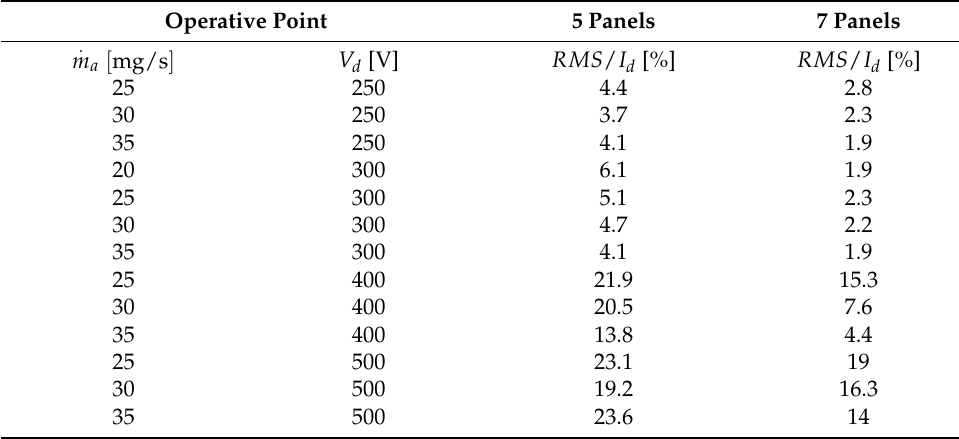
Table A2. RMS / I d for the various operative conditions of the HT20k M. Operative Point 5 Panels 7